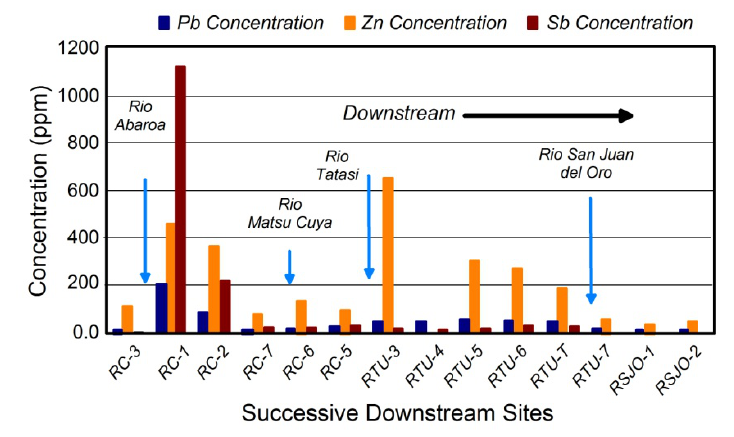
Figure 1. Pb, Zn, and Sb concentrations measured in channel bed sediments of the Rio Chilco-Rio Tupiza drainage system of southern Bolivia. Sb mines are located within the Rio Abaró and Rio Matsu Cuya tributary basins. Polymetallic tin deposits containing limited Sb are located within Rio Tatasi. Point sources of contamination are indicated by abrupt increases in element concentration followed by downstream declines